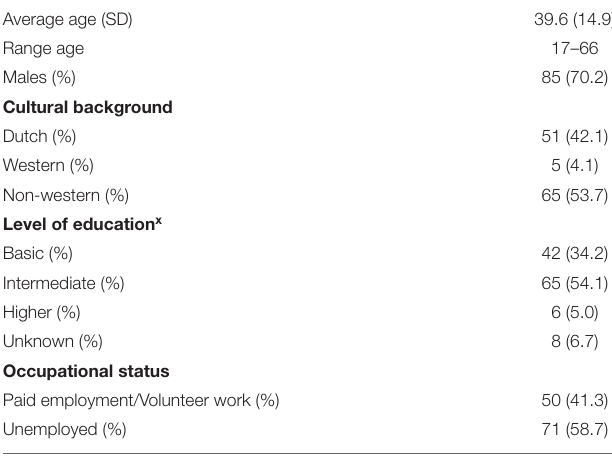
TABLE 1 | Participants’ demographic characteristics ( N =